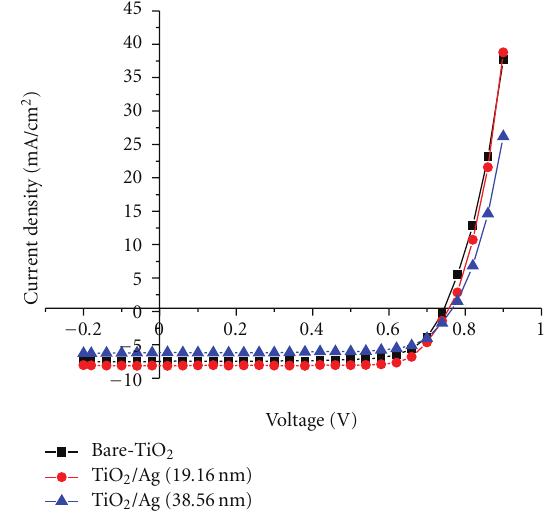
Figure 8: J - V characteristics of the DSCs composed of the TiO 2 electrodes with N719 dye before and after improvement with the Ag